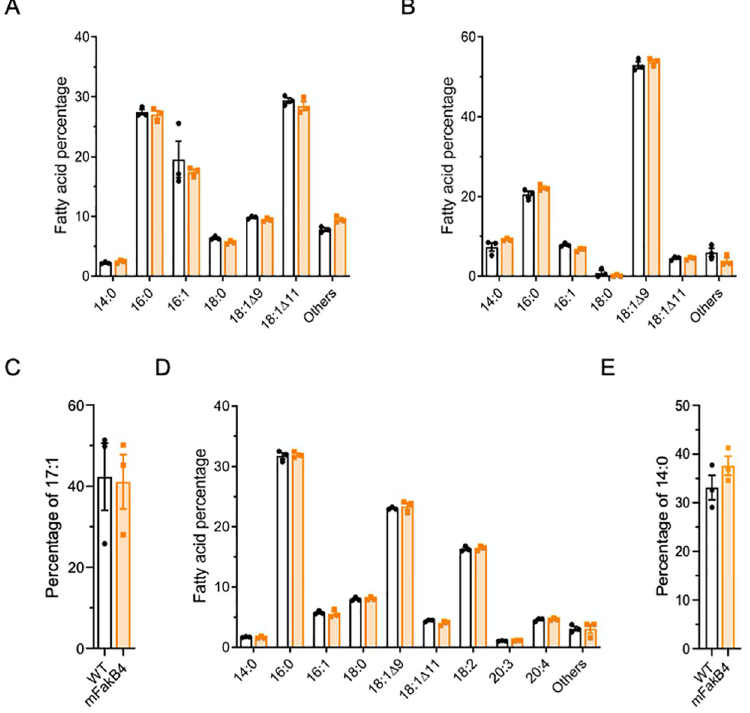
Fig 2. The WT and mFakB4 strains show identical relative FA compositions. A, B, D) Membrane fatty acid percentage of WT and mFakB4 strains grown in A) THY, B) THY-Tween 80, D) THY-Plasma; C, E) Membrane C) 17:1 or E) 14:0 percentage in WT and mFakB4 strains cultivated in THY-17:1 or C14:0; A-D, N = 3 (S1 Table). 2-way ANOVA, Bonferroni